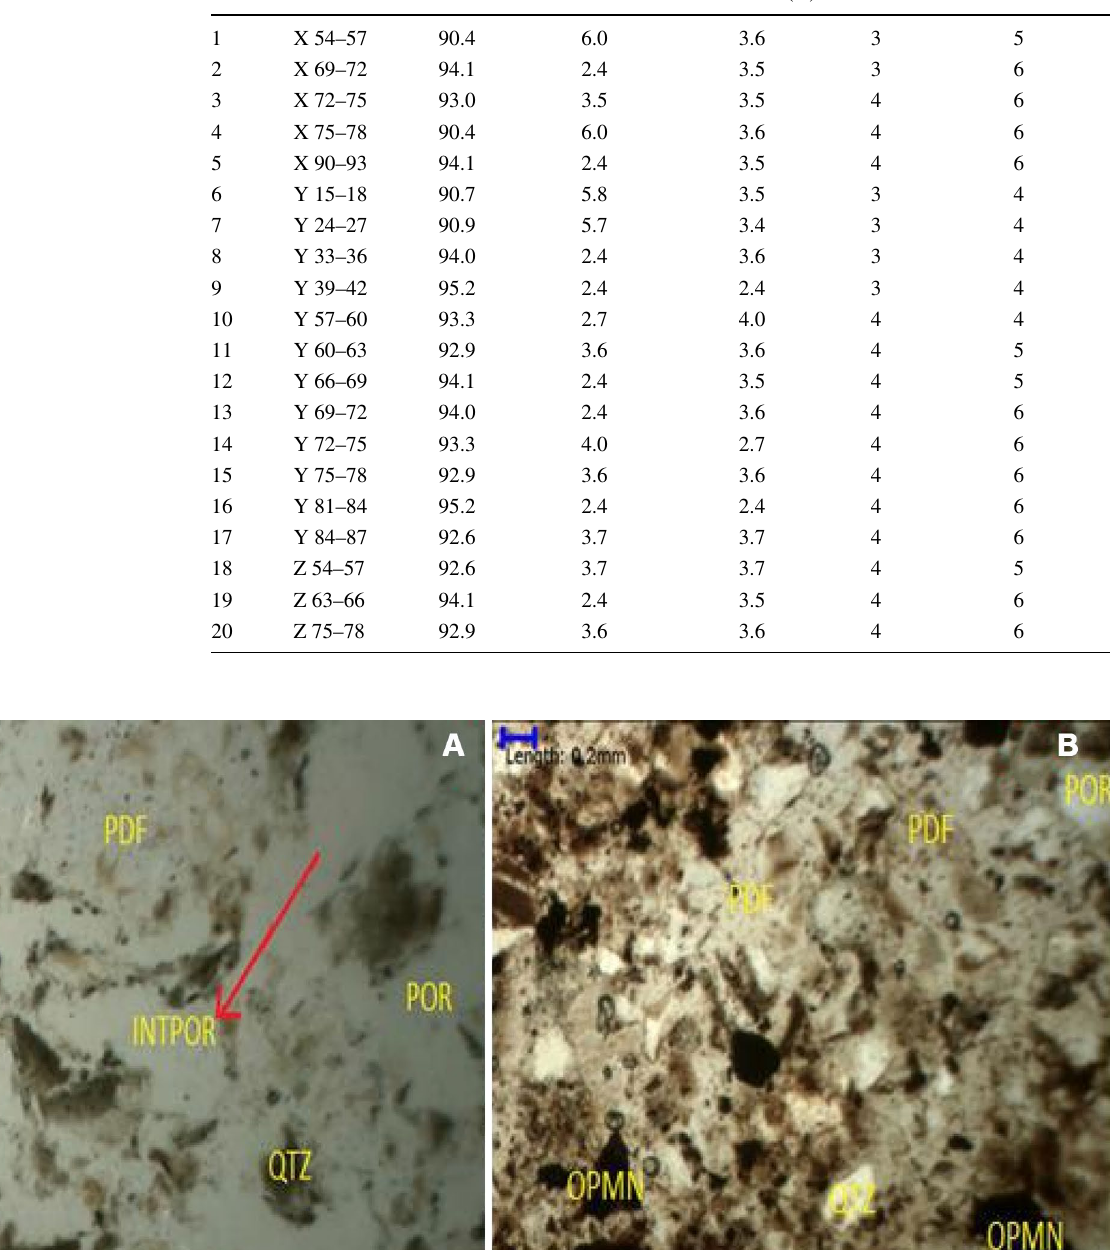
space, OPMN opaque mineral, PDF partial dissolution of feldspar, Por pore space, QTZ quartz